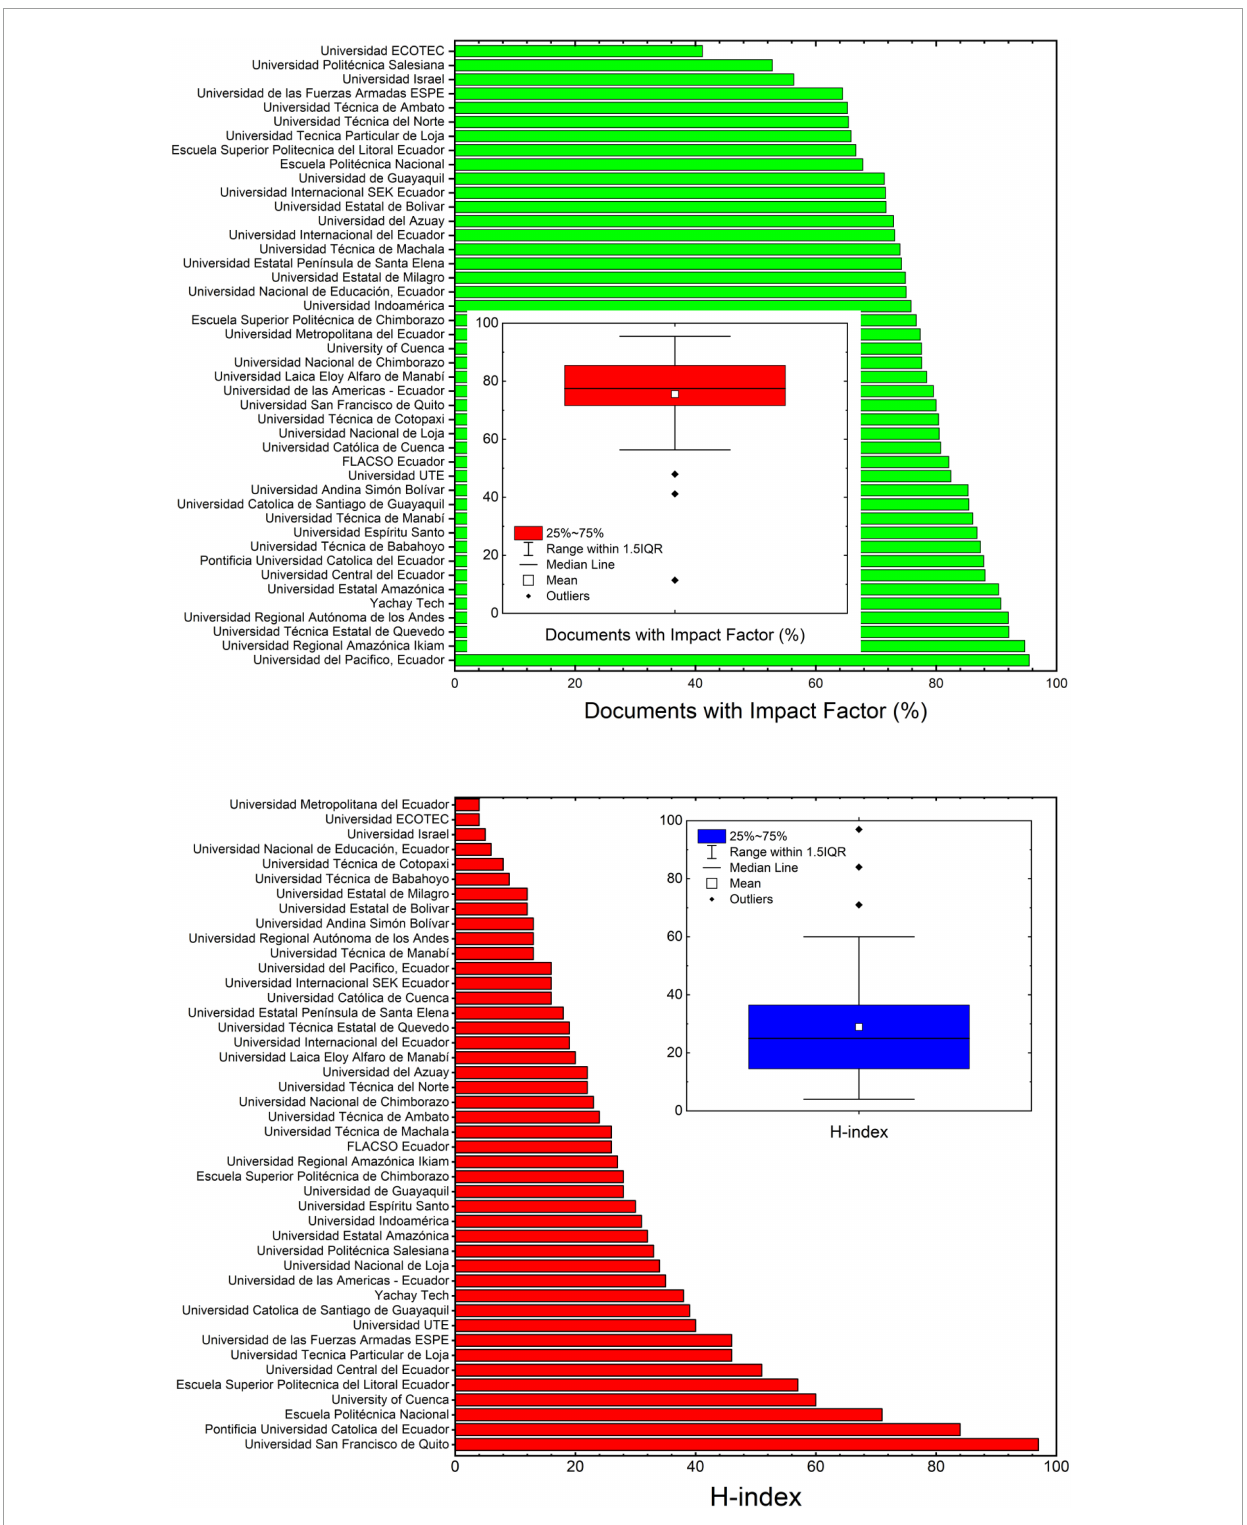
FIGURE3 Percentage of documents with impact factor (Left) , i.e., CiteScore, SNIP, or SJR, and H-Index (Right) of Ecuadorian Universities and their statistical distribution as of 01/28/2022.